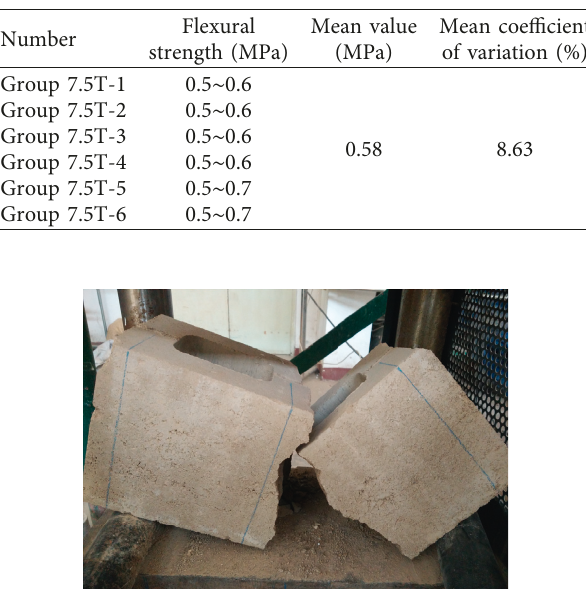
Table 6: Flexural strength tests results for HCCSEBs with strength grade MU7.5.